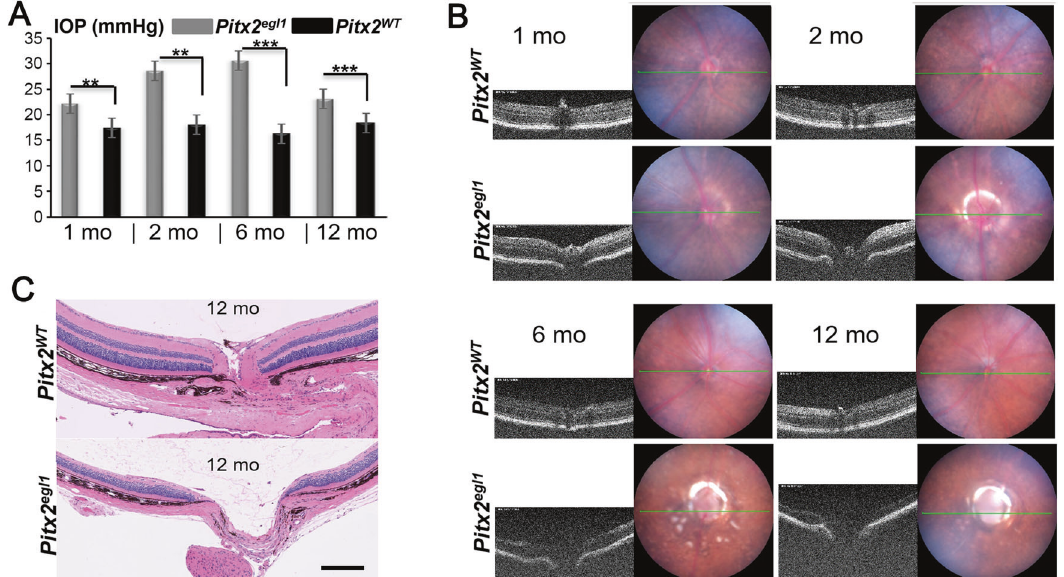
Fig. 1 Pitx2 egl1 mice exhibit an early-onset glaucoma phenotype. A Longitudinal intraocular pressure analysis of Pitx2 WT and Pitx2 egl1 mice ( n = 12 for each group). Intraocular pressure (IOP) measurements with a rebound tonometer (TonoLab) showed a progressive increase in pressure in Pitx2 egl1 mutant mice. IOP (gray bar, egl1 mice = 22.1 ± 3.4 and black bar, WT mice = 17.4 ± 2.2) at 1 month of age. IOP (gray bar, egl1 mice = 28.6 ± 5.0 and black bar, WT mice = 18.0 ± 1.7) at 2 months of age. IOP (gray bar, egl1 mice = 30.6 ± 6.5 and black bar, WT mice = 16.3 ± 1.3) at 6 months of age. IOP (gray bar, egl1 mice = 23.1 ± 1.4 and black bar, WT mice = 18.4 ± 1.7) at 12 months of age. B Representative fundus photographs and optical coherence tomography images of Pitx2 WT and Pitx2 egl1 mice at different ages. A partial ring around optic cup in the fundus and and optic nerve cupping observed by OCT in Pitx2 egl1 mice (bottom row), but not in Pitx2 WT mice (upper rows) at 2, 6, and 12 months of age. The green lines indicate the plane in which the B-scan to the left of the fundus images were taken C Representative images of histologic sections taken through nerve heads from Pitx2 WT and Pitx2 egl1 mice at 12 months of age. Optic nerve head cupping was observed in Pitx2 egl1 mice, with thinning of inner retina layers. Scale bar: 200 μ m. ** P < 0.01; *** P < 0.001. Data are presented as the mean ±